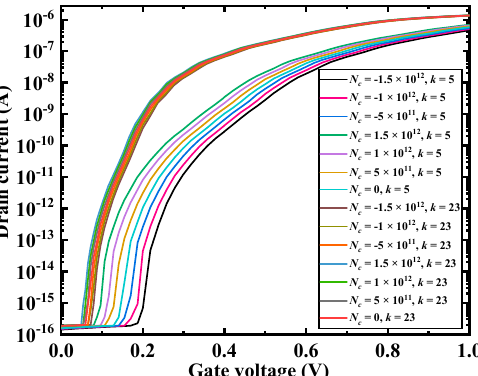
Figure 6. Transfer characteristics of the DM-LTFET biosensor for different dielectric constants and biomolecules charges at V d = 0.5 V, V g = 1 V, and T c = 5 nm.